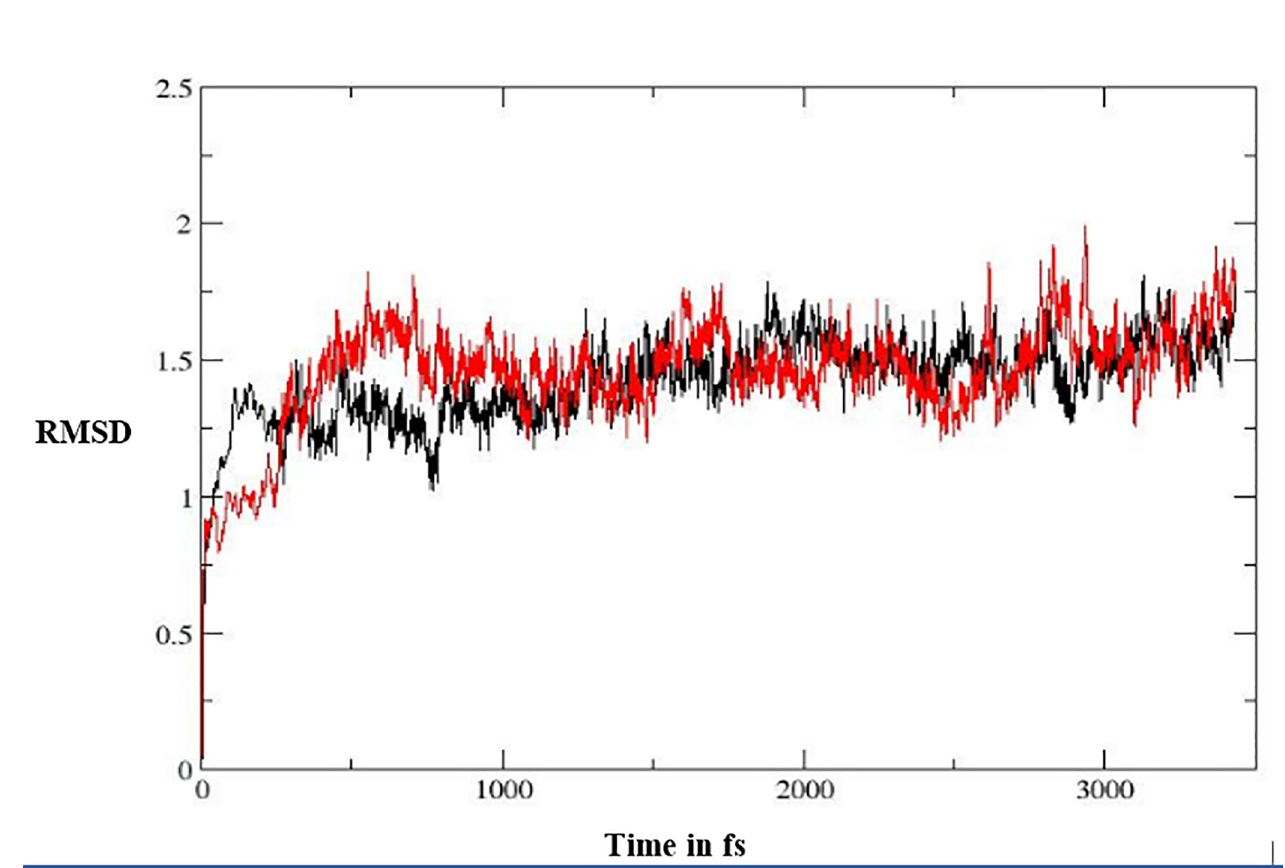
Fig 9. RMSD graph computed for 3.5 ns; the black line represents compound 5i and the red line represents compound 5j.